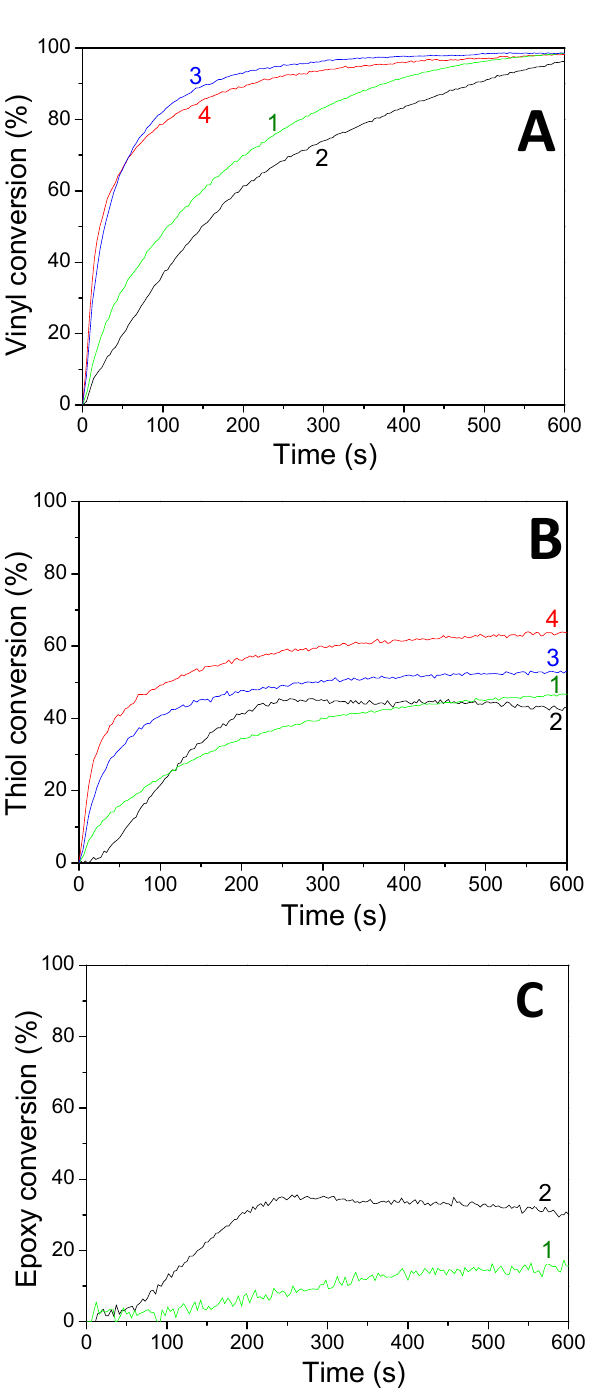
Figure 6. Kinetic profiles for the thiol–ene and cationic photopolymerization of limonene 1,2 epoxide (50wt%)/trithiol (50wt%) blend mixture with HNQA /Iod (0.5/2%, w / w ) photoinitiating system, upon LEDs@ (1) 385 nm and (2) 405 nm irradiation under air; and in laminate under LEDs@ (3) 385 nm and (4) 405 nm. ( A ) Vinyl conversions, ( B ) thiol conversions, and ( C ) epoxy conversions.